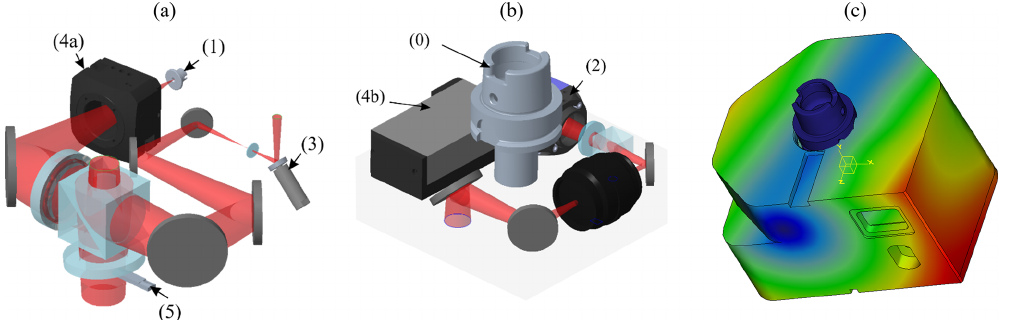
Figure 2. Sketch of the HoloCut sensor head bottom plane (a) and top plane (b) with interfaces to the control unit: camera (2), piezo actuator (3) and rotary stage (4). The machine integration in the center of gravity of the sensor (0) is realized by a 3-D layout of the optical beam path. (c) Finite methods natural frequency simulation of the HoloCut housing: the first eigenfrequency, shown here, is at 323Hz and well above the frequencies occurring in machine tools ( < 300Hz).